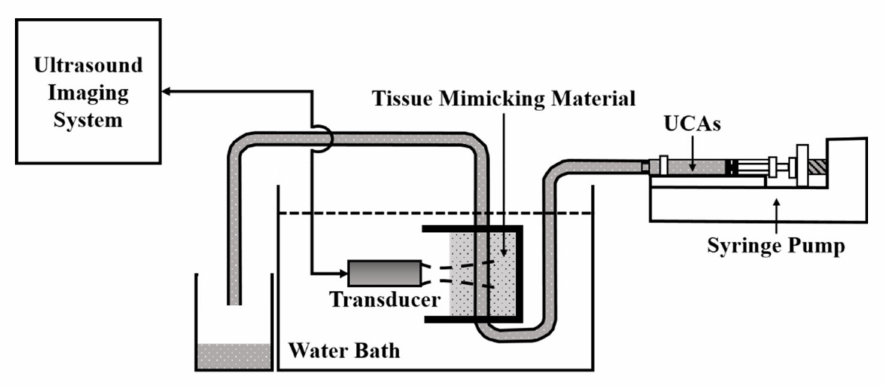
Figure 3. The arrangement for flow phantom